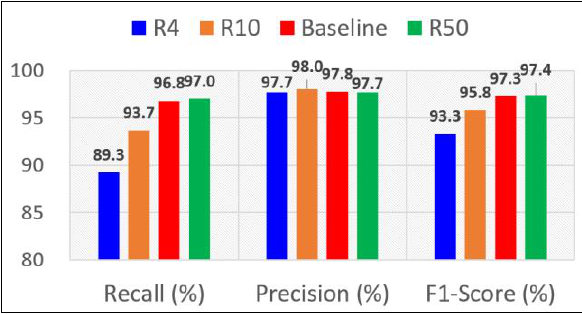
Figure 3 . Effect of different neighborhood